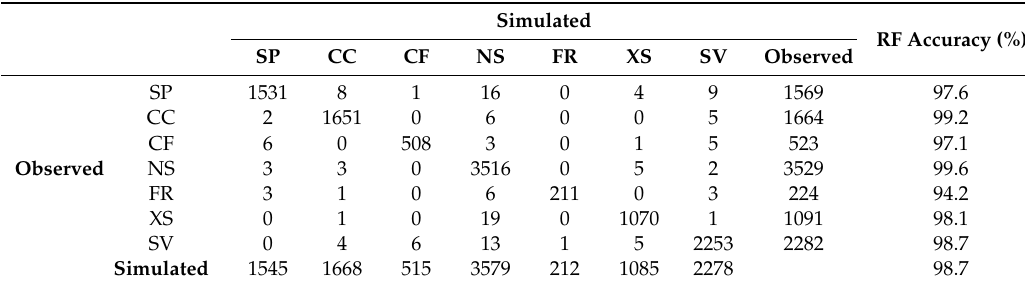
Table 2. Confusion matrix of Random Forest (RF) between observed and simulated pasture macro-types occurrence classification over the Italian Alpine chain for the present period (baseline 1970–2000). RF accuracy is reported in percentage (%). SP stands for pastures encroached by shrub species; CC for pastures dominated by Carex curvula ; CF for pastures dominated by Carex firma ; NS for pastures dominated by Nardus stricta ; FR for pastures dominated by Festuca gr. rubra ; SV for pastures dominated by Sesleria varia and XS for pastures dominated by xeric